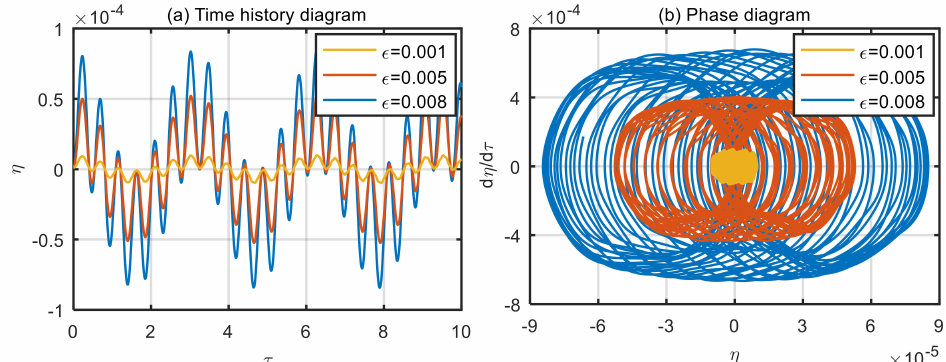
Figure 4. Displacement time history diagram ( a ) and phase diagram ( b ) of microtubes with different dimensionless amplitude of the excitation loads ( u = 1).